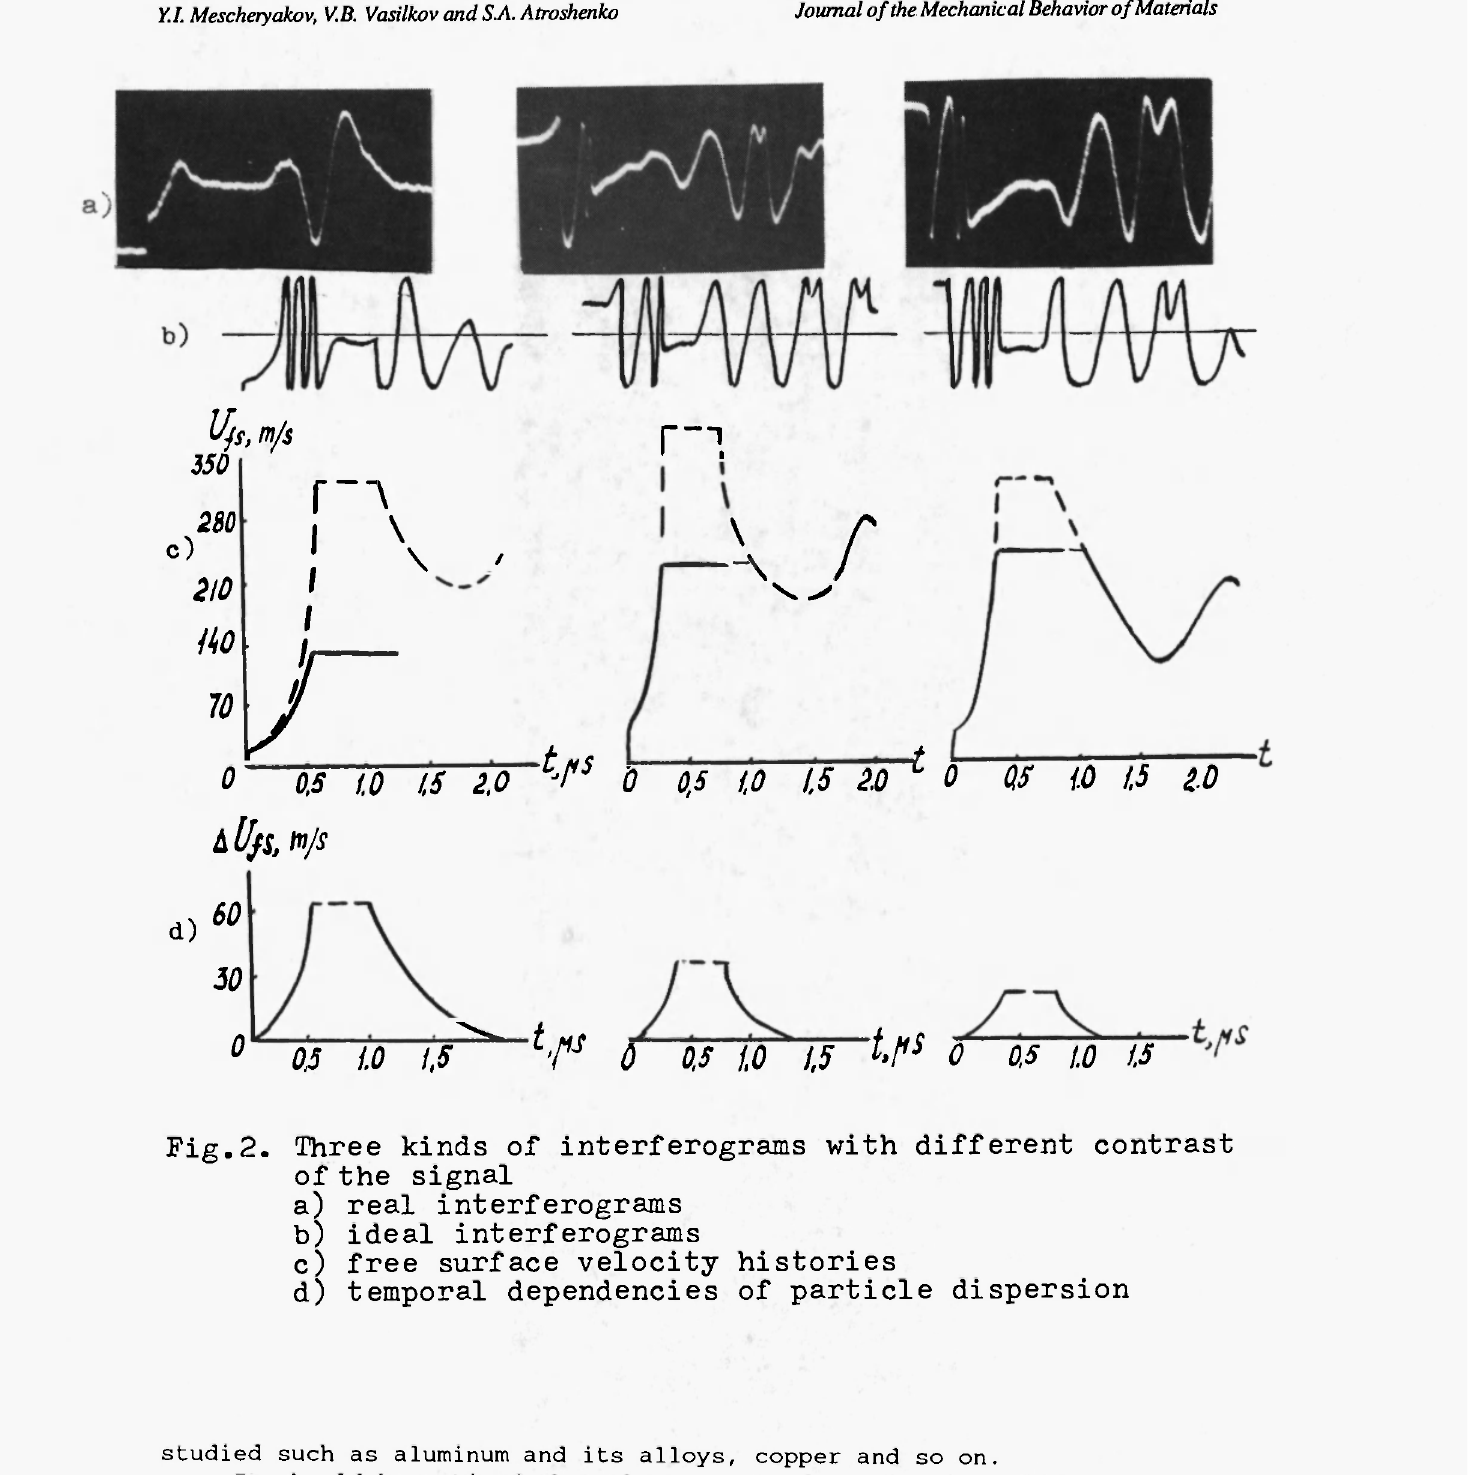
Fig.2. Three kinds of interferograms with different contrast of the